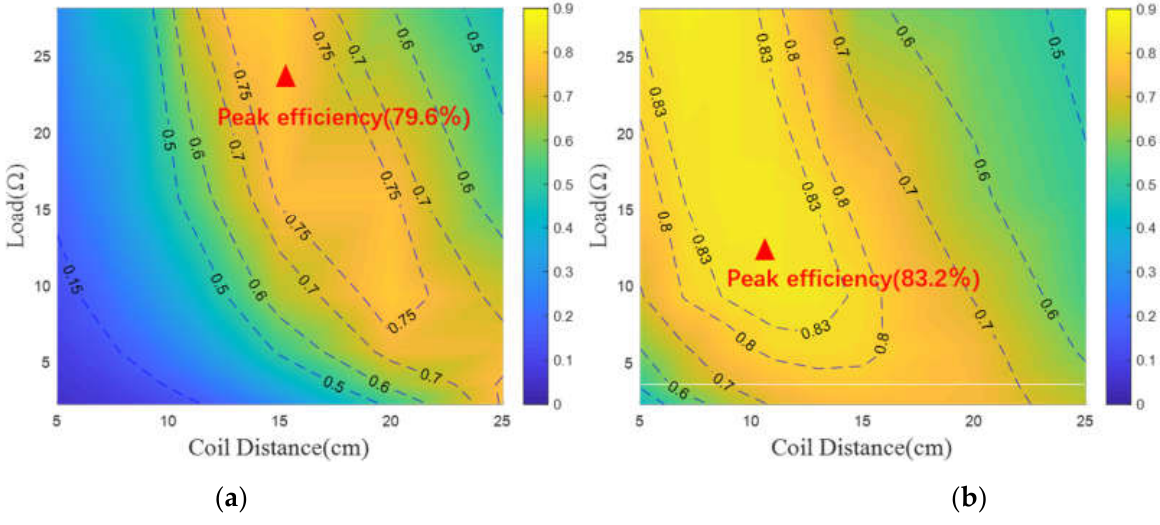
Figure 11. Efficiency of Class-E PA with coil distance and load variation: ( a ) without double-L-type IMN; ( b ) with double-L-type IMN.